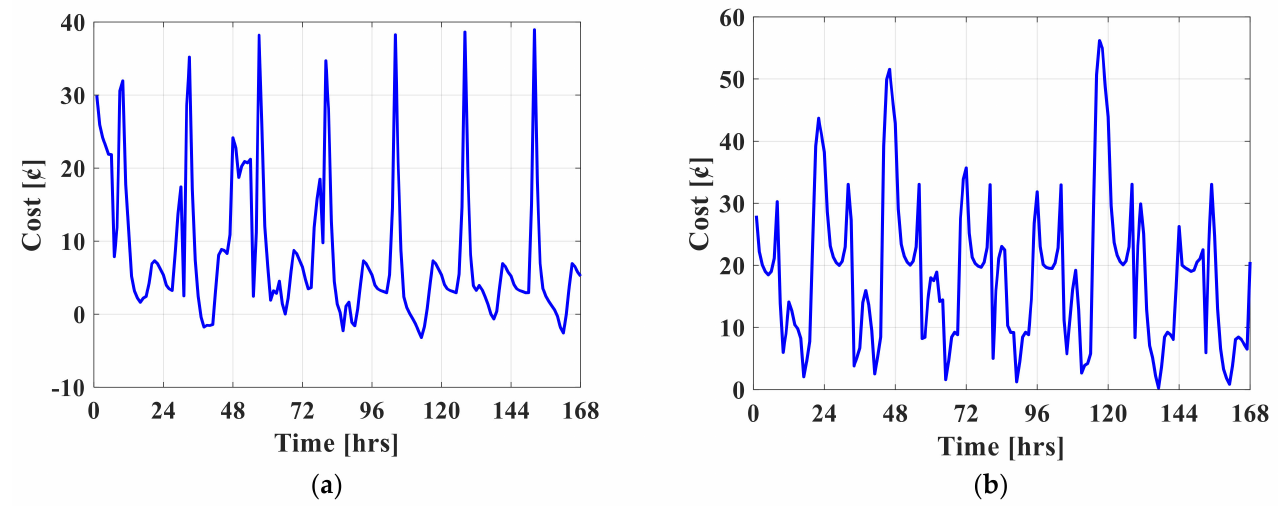
Figure 14. Electricity cost variations under Flat-ToU rates for one week in: ( a ) Summer, and ( b ) Winter.